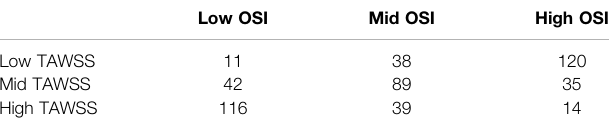
TABLE 2 | Co-occurrence of TAWSS and OSI